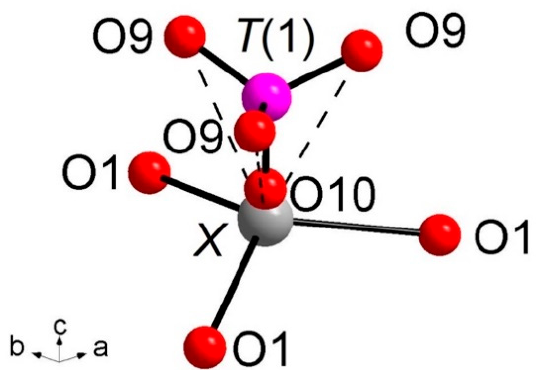
Figure 3. Coordination environments around the X site. X-O(10) = 0.51 Å (NDP), 0.56 Å (XRD). Dashed bond: X-O(9) weak interactions over 2.90 Å. The H(10) atoms and the T (1 ′ )O 3 (OH) split moiety are omitted for clarity.